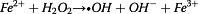
The proposal reaction of caffeic acid to scavenge DPPH· (step 2).